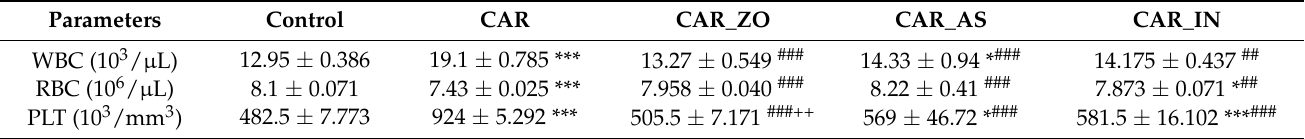
Table 2. Hematological parameters in the different experimental rats: control rats, inflamed rats with CAR (CAR), inflamed rats and treated with ZO (CAR_ZO), inflamed rats treated with AS (CAR_AS) and inflamed rats treated with indomethacin (CAR_IN).